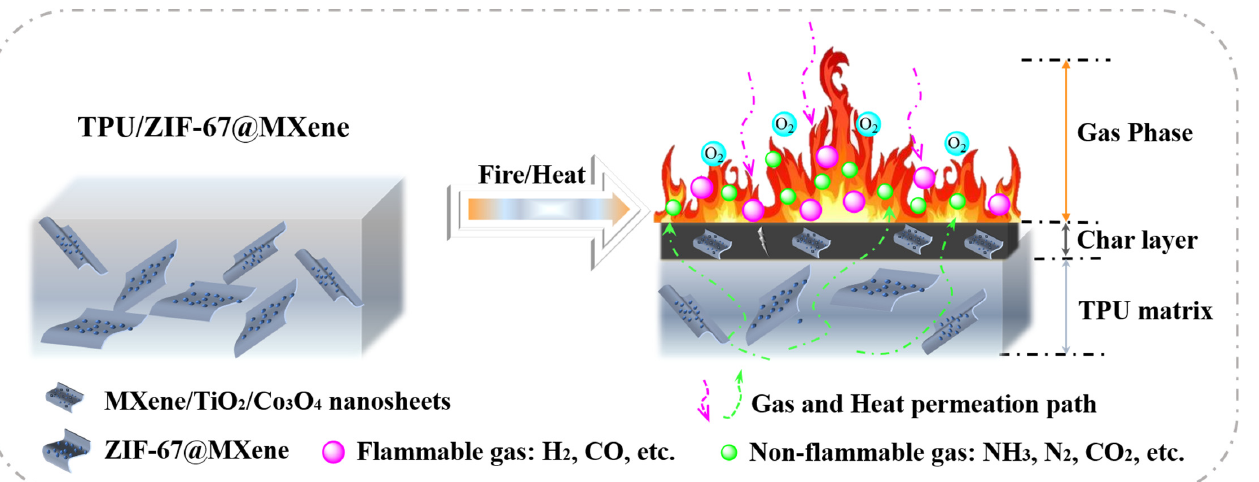
Figure 10. ( a ) XPS survey spectra of the residues of TPU composites; the high-resolution ( b ) Ti 2p, ( c ) Co 2p, ( d ) N 1s, ( e ) C 1s, and ( f ) O1s XPS spectra of the residues of TPU/ZIF-67@MXene compo- sites.